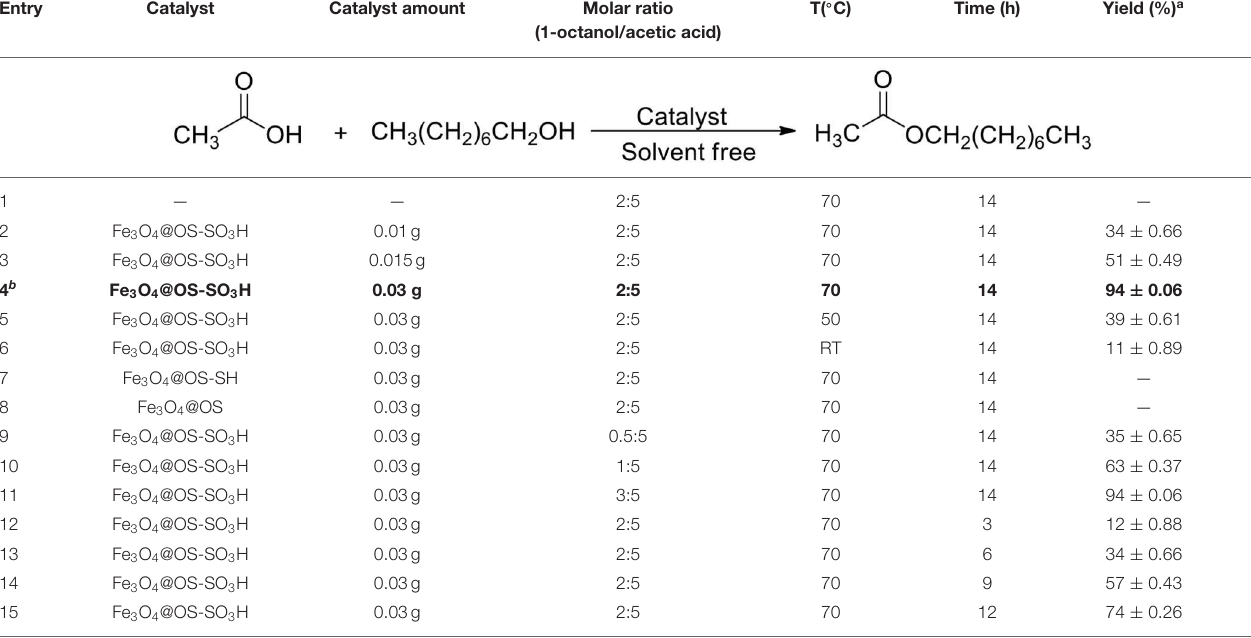
a Isolated yields. b Bold values indicate the optimum